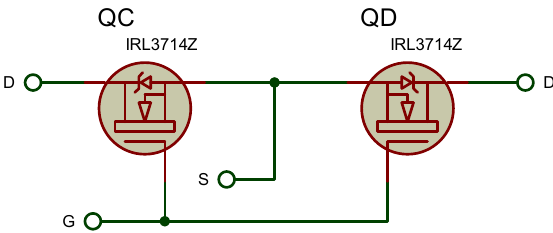
Figure 16. Bidirectional switch using two anti-series